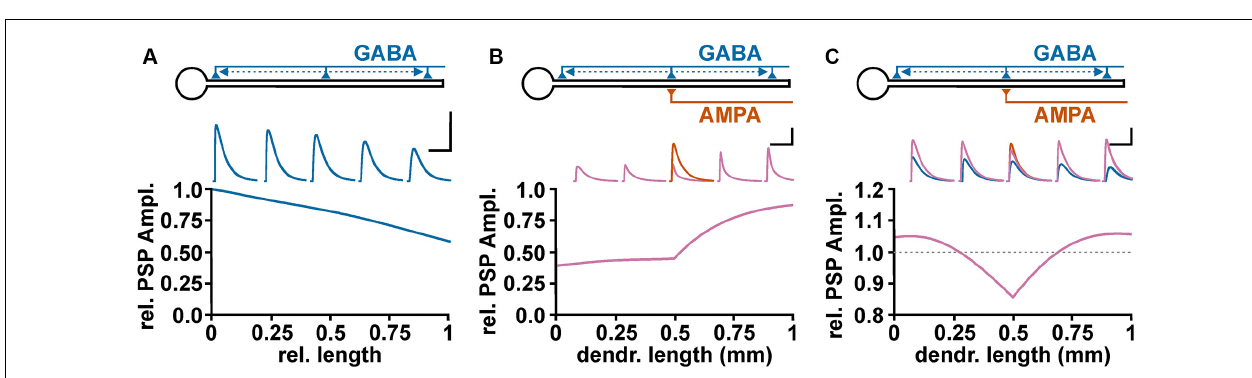
FIGURE 3 | Temporal profile of GABAergic shunting and GABAergic depolarizing effects on excitatory glutamatergic inputs. (A) The upper traces illustrate GABAergic (blue line) and glutamatergic (orange and gray lines) currents provided at latencies between − 150 and +150 ms. The lower traces illustrate the postsynaptic potentials (PSPs) evoked by these currents. Note that the PSPs outlast the synaptic currents. (B) Compound PSPs induced by the co-stimulation of GABA and glutamate synapses, with the glutamatergic inputs provided at latencies between − 150 and +150 ms. (C) Peak amplitude of compound PSP, normalized to the glutamatergic PSP in the absence of GABA, plotted against the latency between AMPA and GABA stimuli, as shown in (B) . Note that the compound PSP amplitude drops if glutamatergic synapses are activated within a narrow interval around coincident stimulation, but increases when AMPA receptors are stimulated several ms after the GABA input.